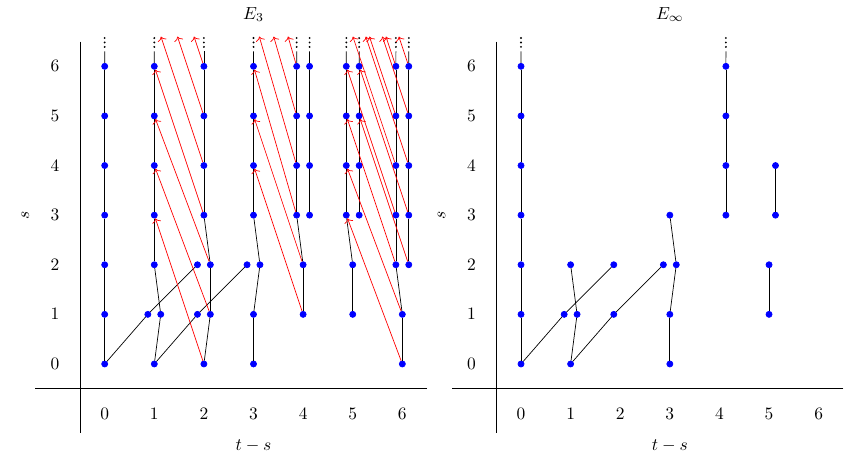
Figure 7: The Adams chart for H • ( B (cid:90) / 2 3 ) .